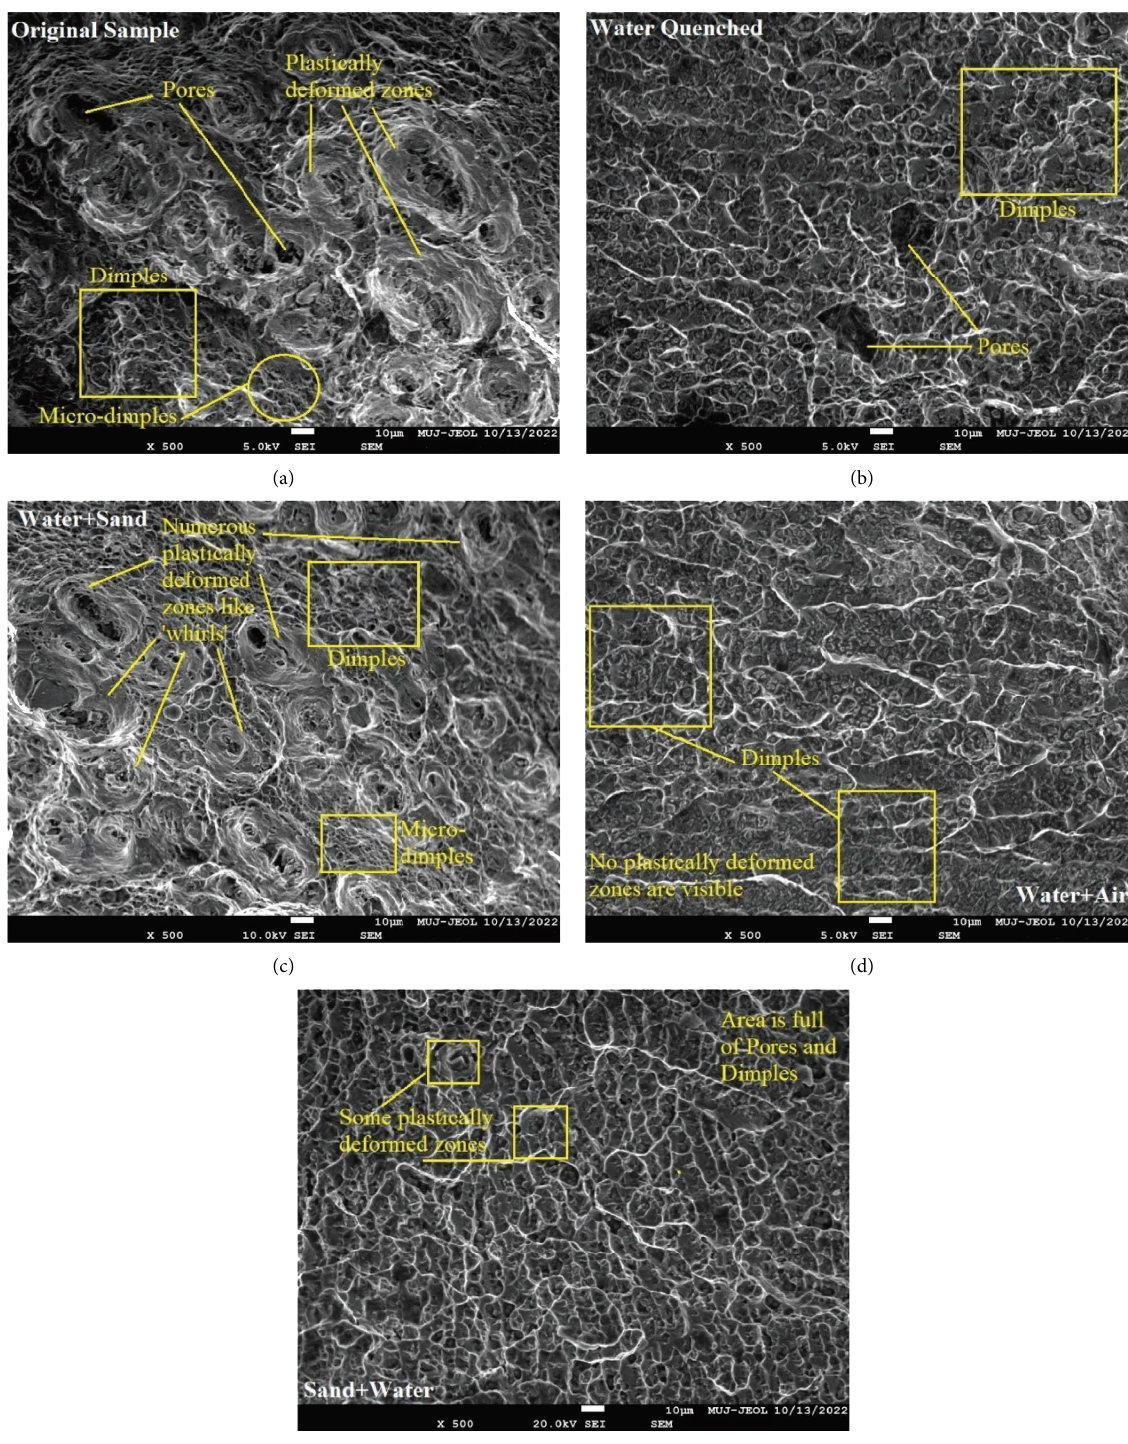
Figure 11: Fractography analysis of broken tensile test